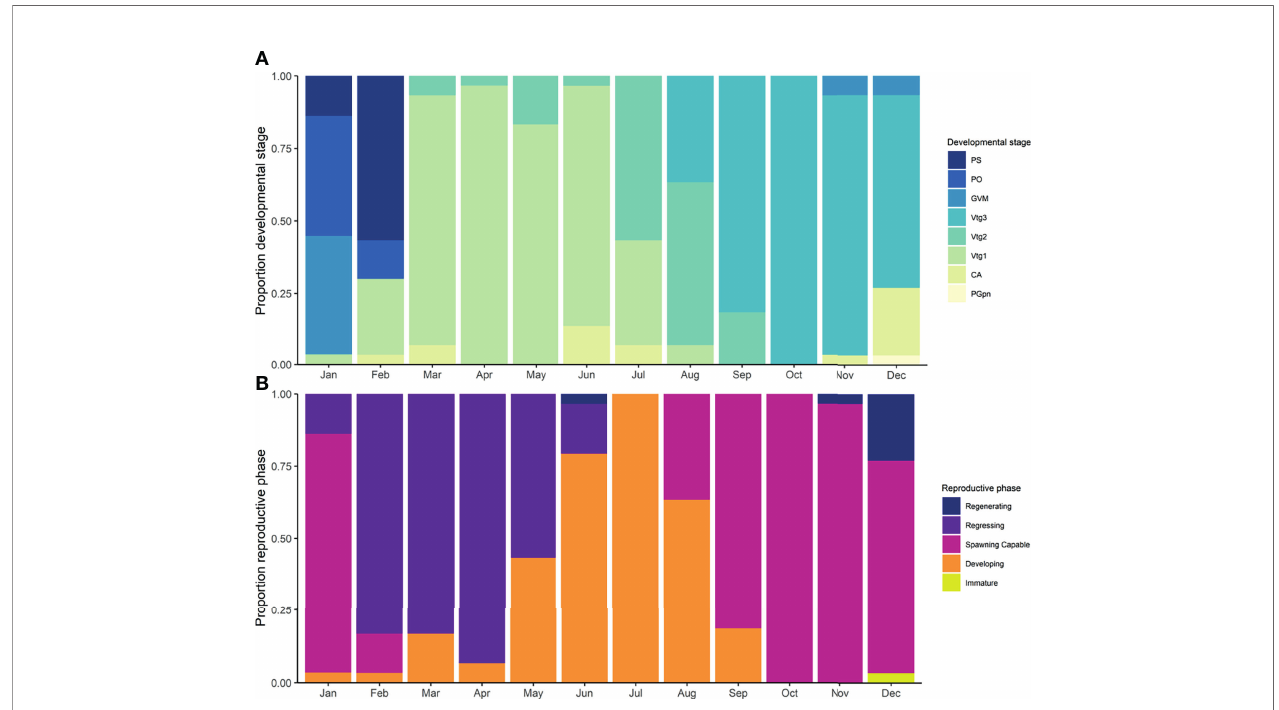
FIGURE 2 | Proportions of developmental stages (A) (Primary Growth Perinuclear, PGpn; Cortical Alveolar, CA; Primary Vitellogenesis, Vtg1, Secondary Vitellogenesis, Vtg2; Tertiary Vitellogenesis, Vtg3; Germinal Vesicle Migration, GVM; Periovulatory, PO; Post-Spawning, PS) of female Paci fi c halibut where yellow is the earliest developmental stage (PGpn) and dark blue is the most advanced stage that occurs just after spawning (PS); and reproductive phases (B) where chartreuse is immature, orange is developing, magenta is spawning capable, and purple and dark blue represent regressing and regenerating